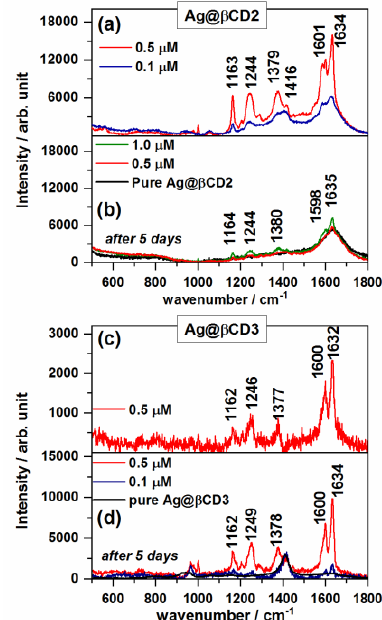
Figure 4. SERS spectra of TCA recorded at different concentrations on ( a ) Ag@βCD2 and ( c ) Ag@βCD3 colloids. The aging effect on the SERS signal after five days is shown in ( b ) and ( d ), respectively.